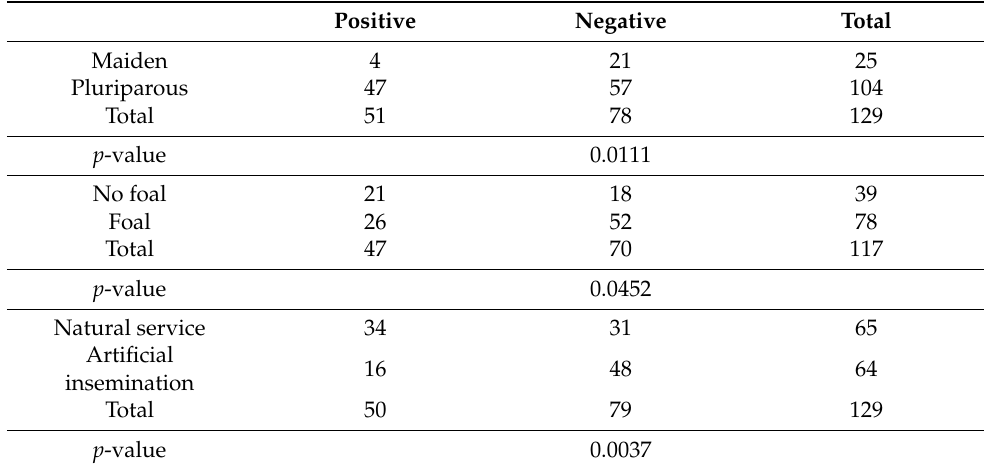
Table 4. EcPV2 genoprevalence of the